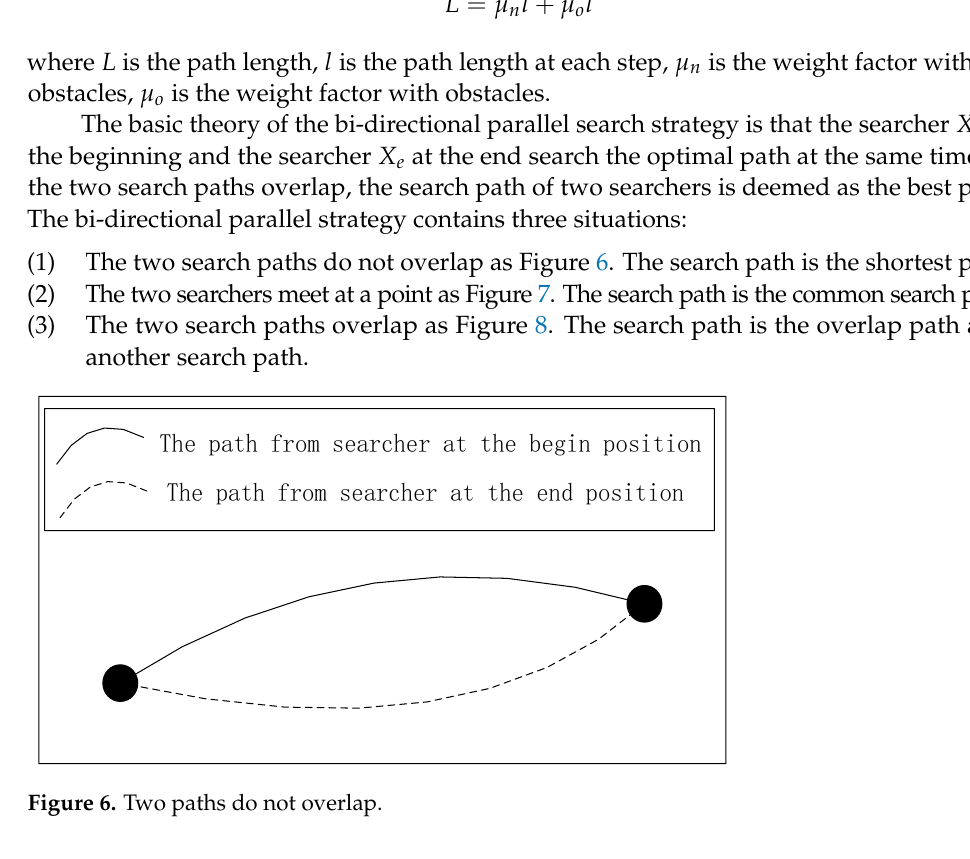
The path from searcher at the begin position The path from searcher at the end position Figure 7. Two searchers meet at a point. The path from searcher at the begin position The path from searcher at the end position Figure 8. Two paths overlap. The simulation annealing algorithm is from the solid annealing principle. The algo- rithm is used in the combinatorial optimization field and adopts an iterative solution strat- egy. The simulation annealing algorithm makes temperature decrease from a large value at certain parameters based on the principle of temperature drop. The procedure of up- dating food source with the simulation annealing algorithm is as follows: (1) Initialize starting temperature value. (2)